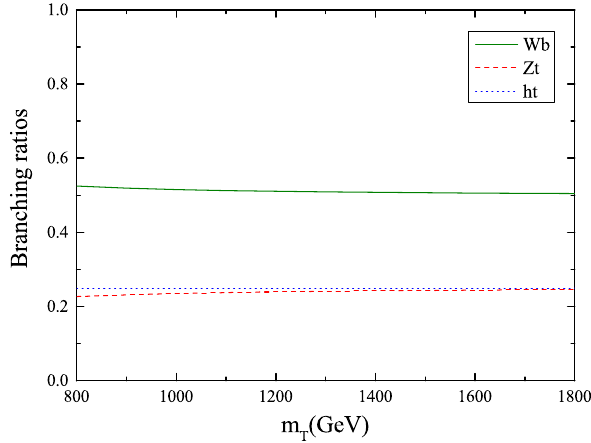
Fig. 1 Branching ratios of the top partner decay